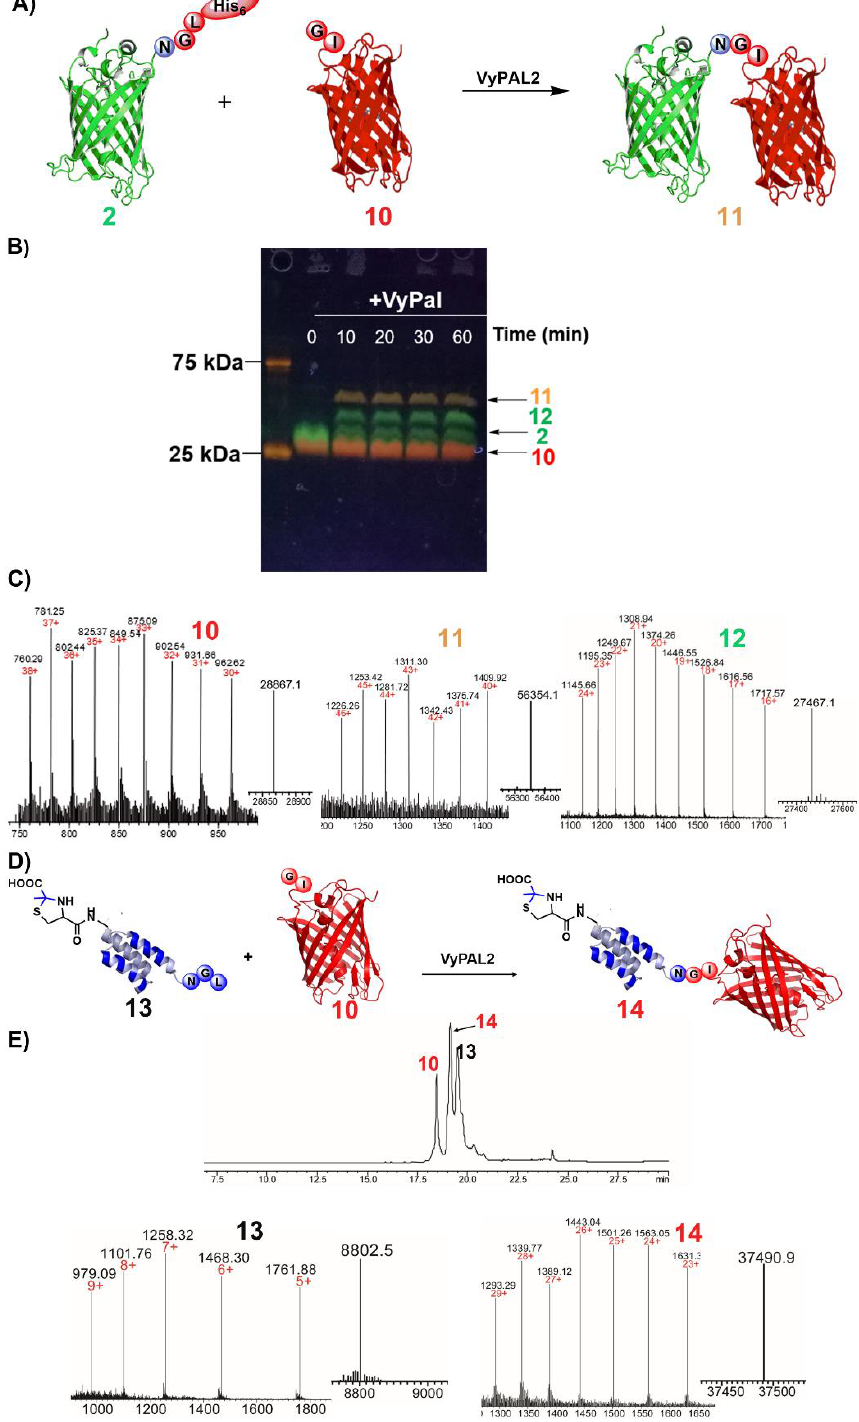
Figure 3. VyPAL2-mediated inter-protein ligation. ( A ) Schematic illustration of ligation reaction between the green fluorescent protein sfGFP engineered with a C-terminal tripeptide “NGL” 2 and the red fluorescent protein GI-mCherry 10 . ( B ) Fluorescent gel analysis of the ligation reaction between sfGFP-NGL 2 and GI-mCherry 10 catalyzed by VyPAL2. Aliquots of the reaction mixture were taken out and frozen at different time points, and, at the end, subjected to SDS-page gel elec- trophoresis. ( C ) ESI-MS characterization of GI-mCherry 10 , inter-protein ligation product 11 , and the cyclic by-product 12 ( 10 : calcd mass 28,860.4 and obsvd mass 28867.1; 11 : calcd mass 56,350.5 and obsvd mass 56,354.1; 12 : calcd mass 27,474.9 and obsvd mass 27,467.1). ( D ) Schematic illustra- tion of the ligation reaction between the EGFR-targeting affibody Z EGFR tagged with the C-terminal tripeptide “NGL” 13 and the red fluorescent protein GI-mCherry 10 . ( E ) HPLC and ESI-MS analysis